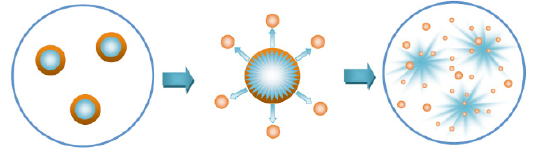
Figure 1. Emulsions in diesel engines [10].